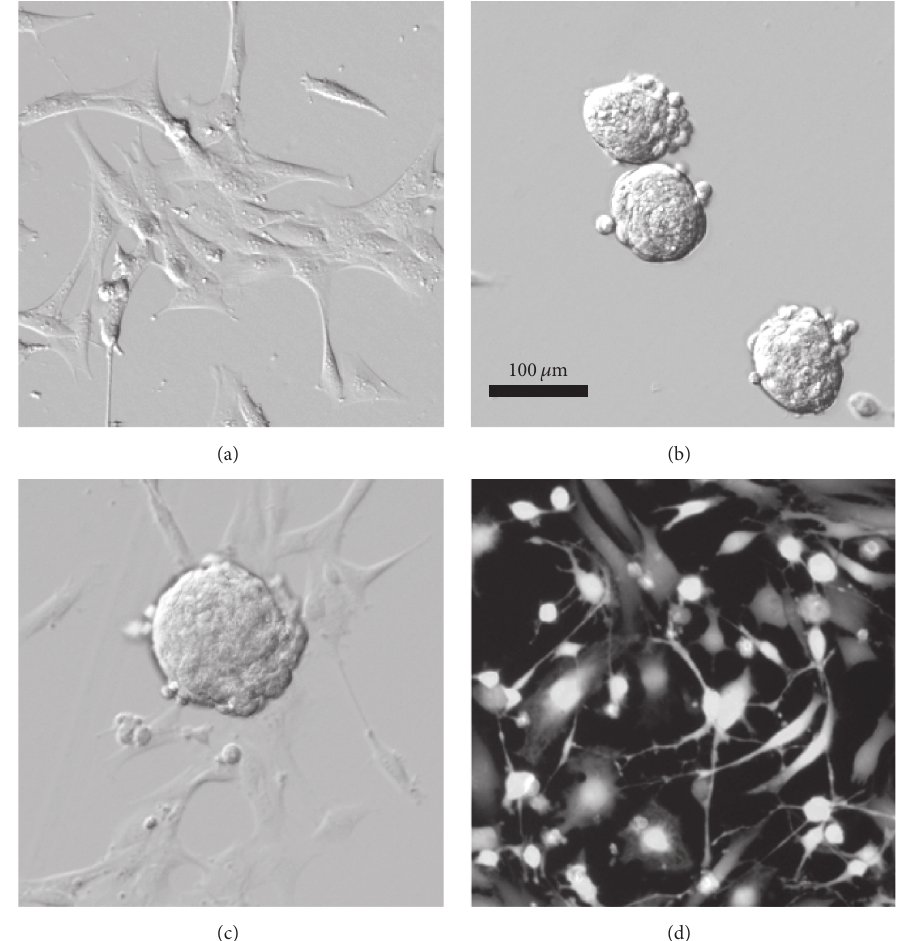
Figure 3: Morphology of mouse M¨uller glia in growth, neurosphere, and differentiation cultures in vitro. Conditionally immortalized mouse M¨uller glia (ImM10 cell line) at different stages of in vitro differentiation as previously described [61]. (a) ImM10 cells in growth media (Neurobasal,2%fetalbovineserum,B27supplement,andpenicillin/streptomycin)underimmortalizingconditions(33 ∘ C,50 U/mlinterferon gamma) show typical morphology of cultured M¨uller glia. (b) ImM10 cells following 4 days in sphere forming medium (Neurobasal, B27 supplement, and modified G5 supplement with 20 ng/ml EGF, 20 ng/ml FGF2, and penicillin/streptomycin) in nonimmortalizing conditions to prevent T-antigen expression (39 ∘ C, without interferon gamma), showing typical nonadherent neurospheres. (c) Spheres at 1 day following transfertoprimingmedium(Neurobasal,G5supplementmodifiedtocontainEGF(20 ng/ml)butwithoutFGF2,andpenicillin/streptomycin; nonimmortalizing conditions), neurospheres adhere to plate, and cells begin to migrate onto dish. (d) Following priming, ImM10 cells in differentiation medium (Neurobasal, B27, and pen/strep; nonimmortalizing conditions) for 2 days and stained with CalceinAM show variable morphologies and include cells with distinct neuronal morphology (small cell body, multiple thin processes).